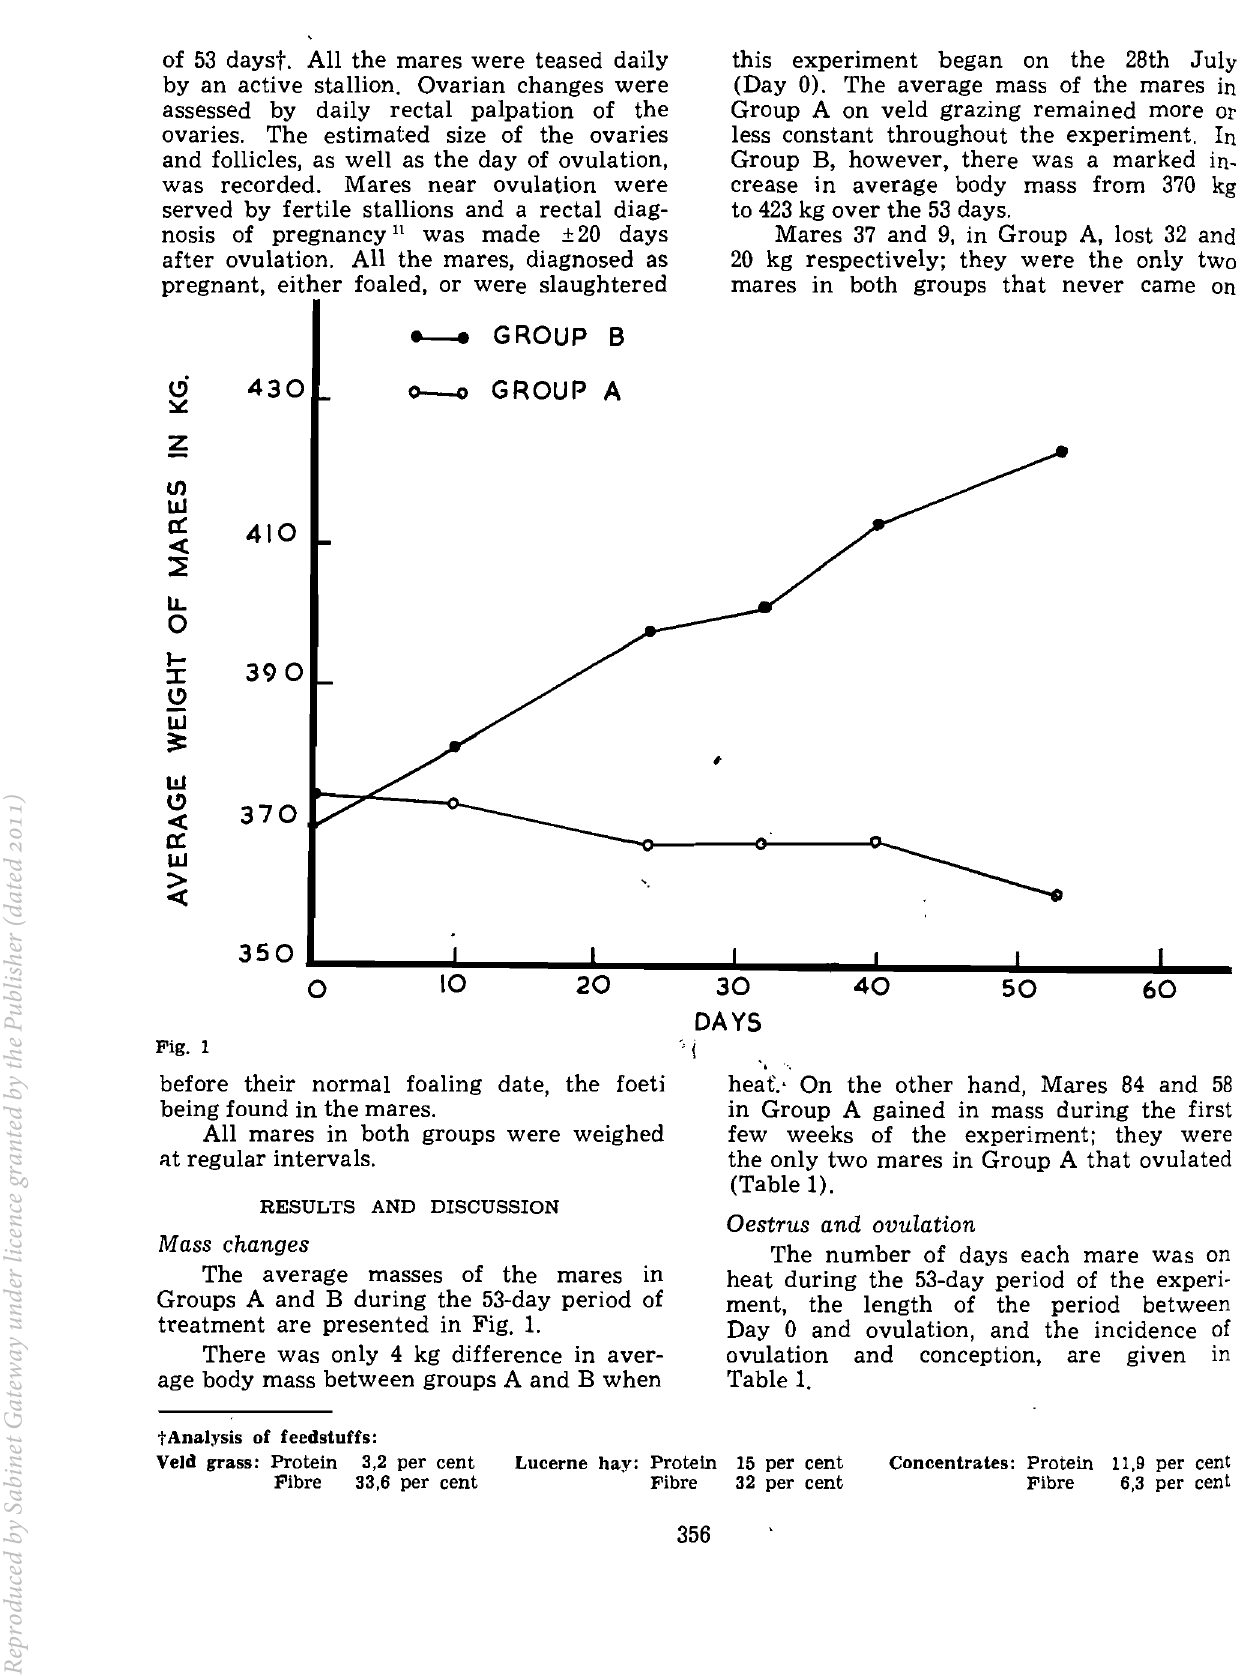
Veld grass: Protein 3,2 per cent Lucerne hay: Protein 15 per cent Concentrates: Protein 11,9 per cent